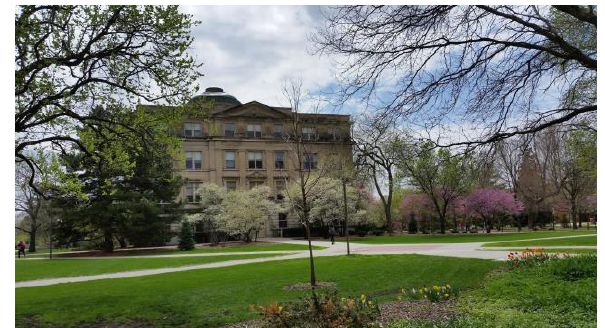
Figure 8. Iowa State University